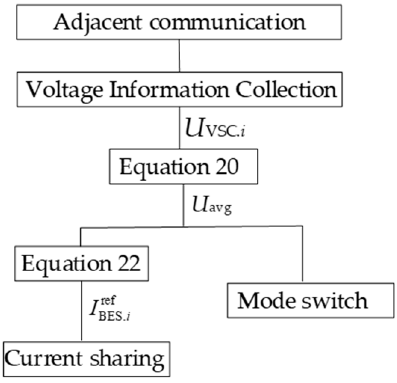
Figure 7. The current-sharing layer strategy based on the difference discrete consensus algorithm.